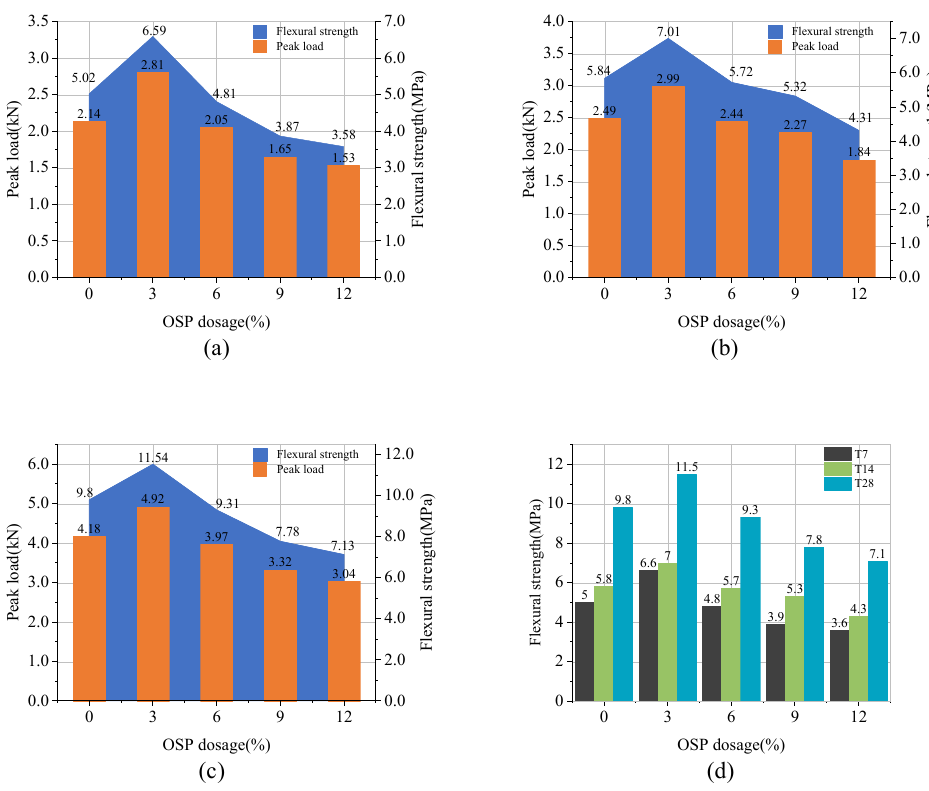
Figure 10. Flexural strength and peak load. ( a ) T7; ( b ) T14; ( c ) T28; ( d ) summarized value of three groups.